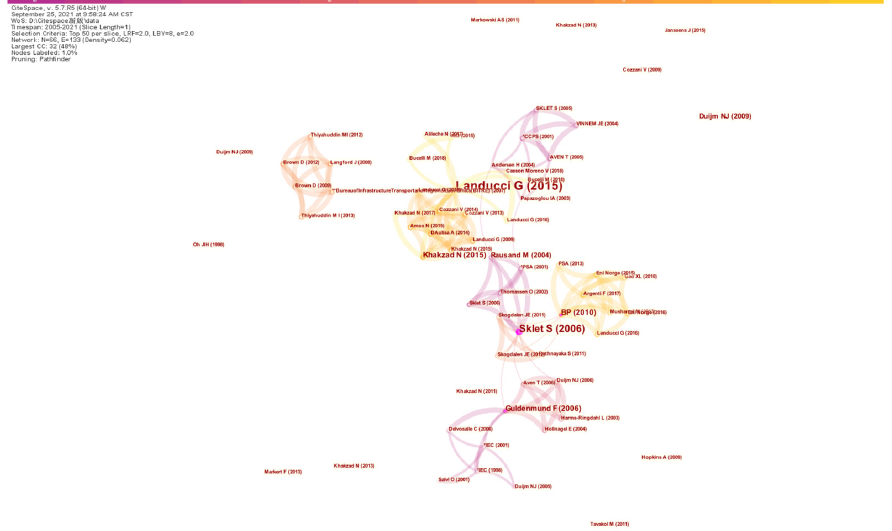
Figure 7. Network of papers-relatedness based on citations. Table 2. Top 10 papers by number of global citations.